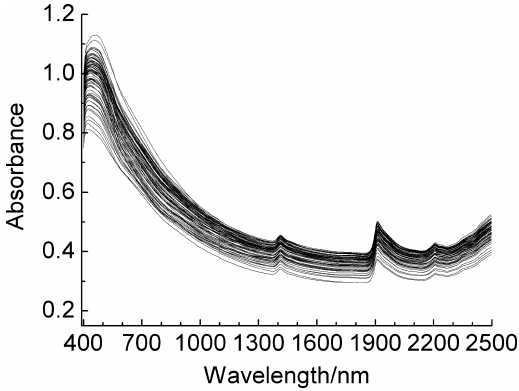
Fig. 2. Visible and NIR spectra of the 163 soil